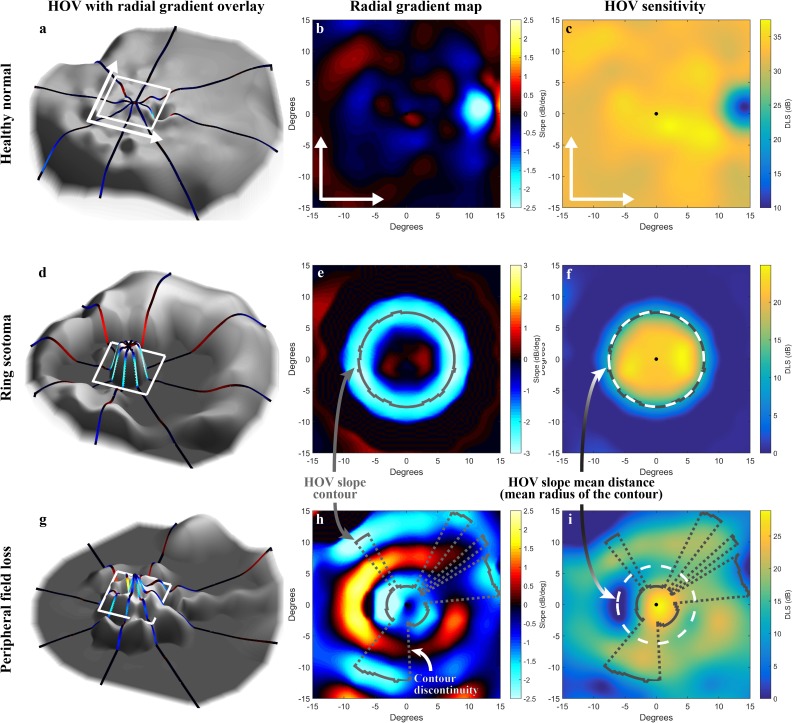
HOV slopes.Each row illustrates a different visual field pattern. (a,d,g) Full-field HOV sensitivity surfaces (gray) overlaid with eight radial spokes color-coded by slope. The white box and arrows indicate the location and orientation of the central 30° region. (b,e,h) The radial gradients of the HOV in the central 30°, with a gray line indicating the HOV slope contour. Discontinuities along the contour are indicated by a dotted gray line. (c,f,i) Top-down view of the HOV sensitivity surfaces. The radius of the white dashed circle is the mean radial distance to the HOV slope contour from the center point (d∇S,AVG). The ring scotoma example is from the same data as Fig 3C–3E.